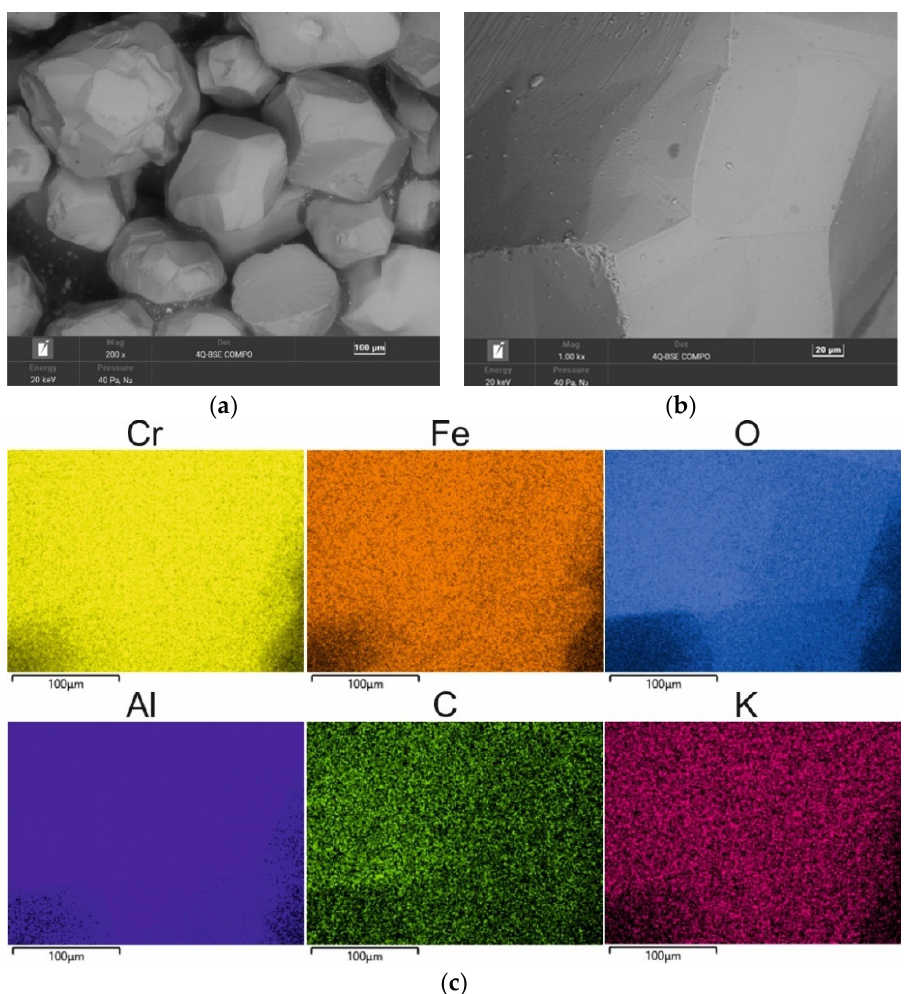
Figure 3. SEM image of chromite sand CS: ( a ) mag. 200×; ( b ) mag. 1000×; ( c ) EDS map of element distribution in the analysed area of chromite sand CS.